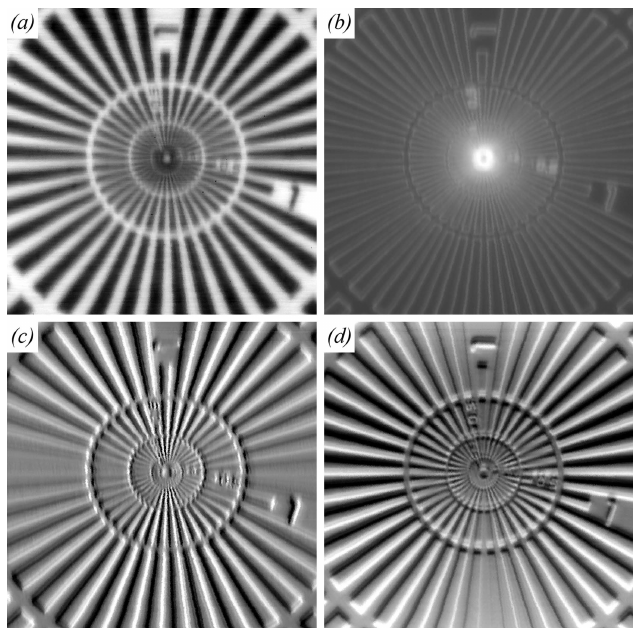
Figure 1 Scanning transmission X-ray microscopy (STXM) images representing ( a ) transmission, ( b ) darkfield (scattering, shown on a logarithmic scale), and ( c ) and ( d ) differential phase contrast in horizontal and vertical directions, respectively. Each 100 nm wide pixel in these 50 m m (cid:3) 50 m m images is calculated from a single detector frame and the spatial resolution is limited by the beam size, here 350 nm (cid:3) 550 nm in the focal